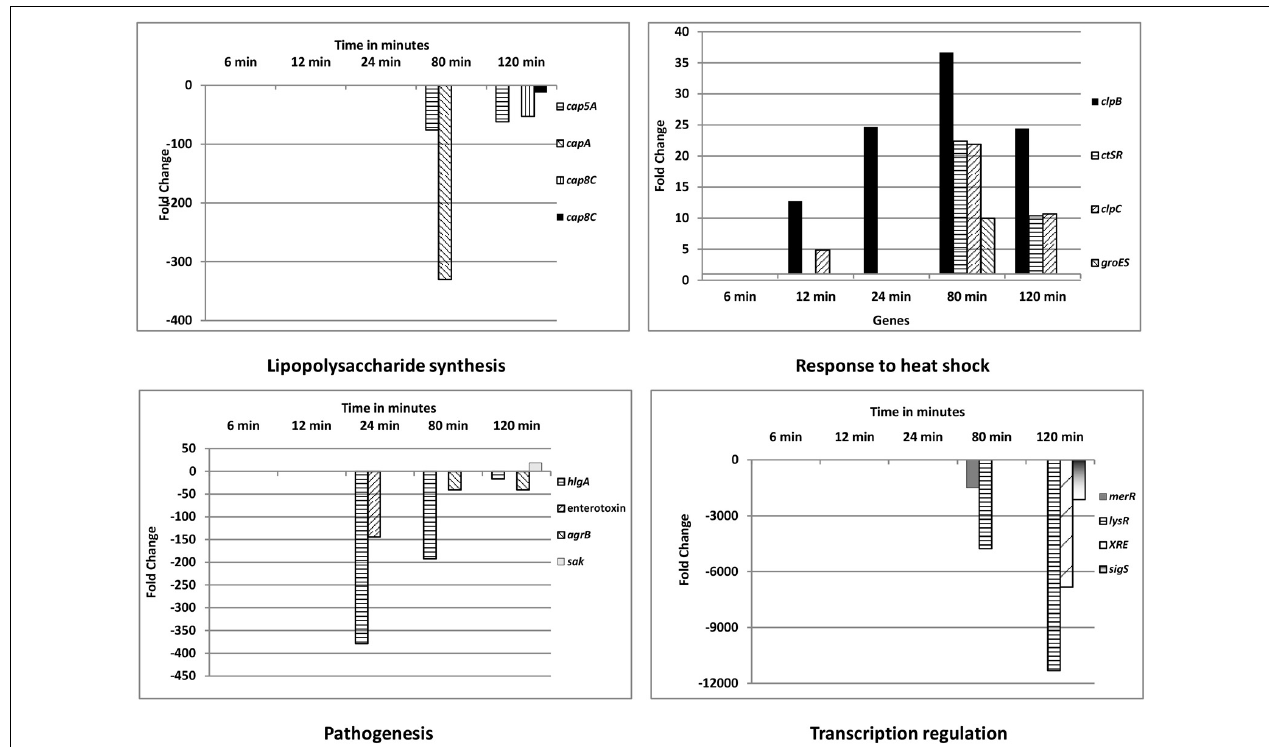
FIGURE 4 | Gene Ontology (GO) categories of differentially expressed genes of S. aureus 04-02981 exposed to AGXX R (cid:13) for different time-periods. Only significantly differentially expressed genes, which are likely relevant in the response of S. aureus to AGXX R (cid:13) , are presented. Details on the other genes are provided in the Supplementary Table S5 , along with all of the other GOs, Gene IDs, and fold-change in gene expression, for each time-point. Capsular polysaccharide synthesis mediating cap genes are shown in ‘Lipopolysaccharide synthesis.’ Genes encoding chaperone ClpB ( clpB ), transcriptional regulator CtsR ( ctsR ), ATP-dependent Clp protease ATP-binding subunit ClpC ( clpC ), and chaperonin GroES ( groES ) are presented in the panel showing response to heat shock. In the pathogenesis panel, the genes for γ -hemolysin subunit A ( hlgA ), enterotoxin, accessory gene regulator subunit B ( agrB ), and staphylokinase ( sak ) are presented. Among the transcriptional regulator genes, that of the LysR family transcriptional regulator ( lysR ), MerR family transcriptional regulator ( merR ), XRE family transcriptional regulator ( XRE ) and RNA polymerase sigma factor SigS ( sigS ) are